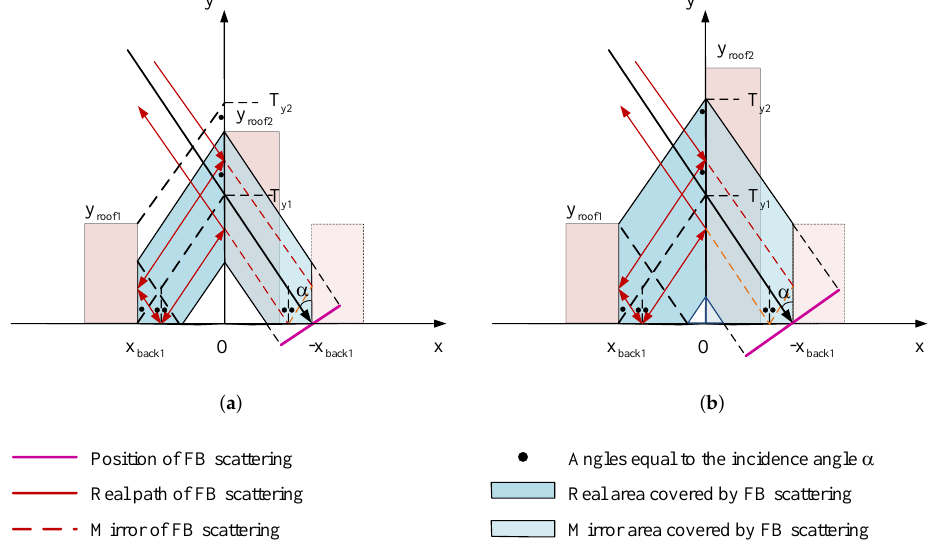
Figure 6. Schematic of FB scattering distribution between combined buildings of airborne array TomoSAR. ( a ) Case 1. ( b ) Case